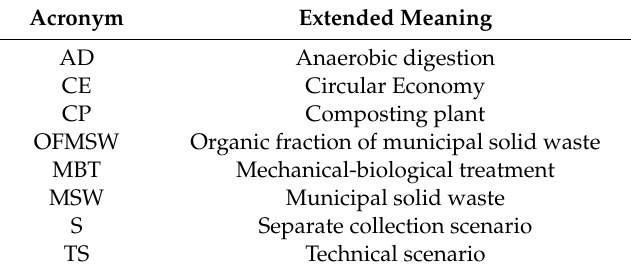
Table 2. List of acronyms used in the